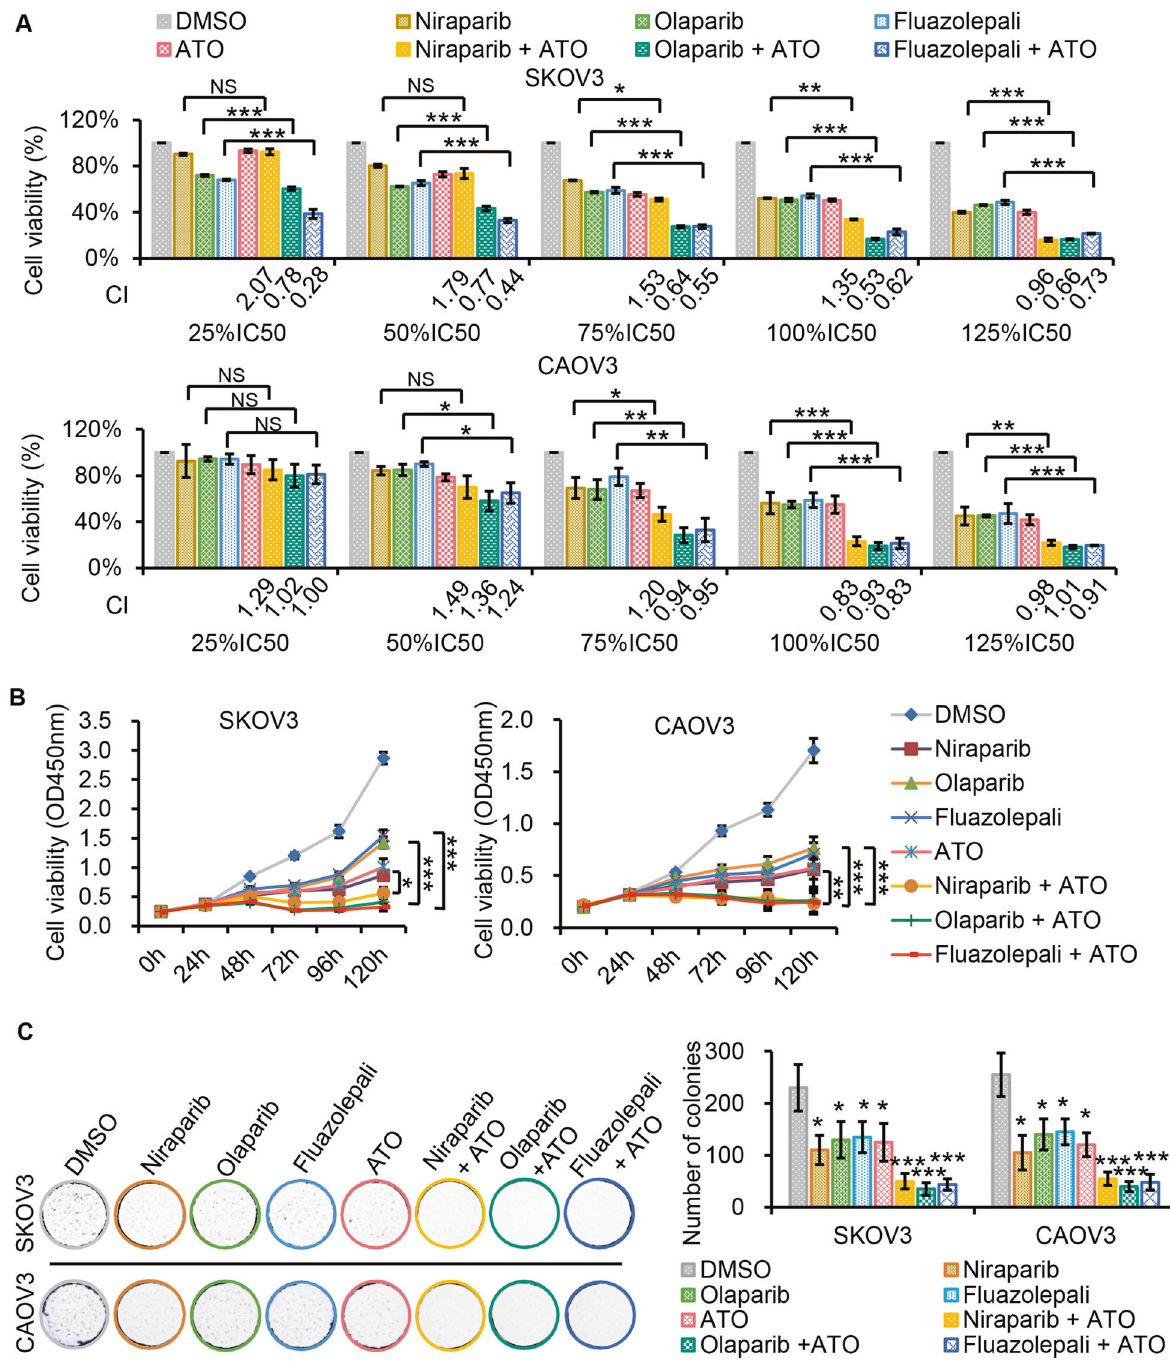
Fig. 2 ATO-PARP inhibitor cotreatment decreases cell viability and colony formation. A Synergy analysis for ATO and PARP inhibitors, niraparib, olaparib, or fl uazolepali, in HR-pro fi cient SKOV3 and CAOV3 cells. Cells were treated with the indicated concentrations of ATO and niraparib or olaparib or fl uazolepali for 72 h. Cell viability was detected by CCK8 assay. The combination index (CI) value was determined by CompuSyn software. CI value indicates the following: >1, antagonism; = 1, additive effect; and <1, synergism. Bars indicate mean ± SD and are representative of three biological experiments. B Cells were treated with ATO or niraparib or olaparib or fl uazolepali or ATO-niraparib or ATO- olaparib or ATO- fl uazolepali using IC50 of each drug, and the cell viability was analyzed by time-lapse imaging for 120 h in the continued presence of drugs by CCK8 assay. Values represent the mean from three technical replicates. C Colony formation assays demonstrated synergy for the combination of ATO with niraparib or olaparib or fl uazolepali in SKOV3 and CAOV3 cells. The concentration of these drugs used in this experiment was 10% of IC50. Representative images are shown of three independent experiments. Bars indicate mean ± SD and are representative of three biological experiments. * P < 0.05; ** P < 0.01; *** P < 0.001.